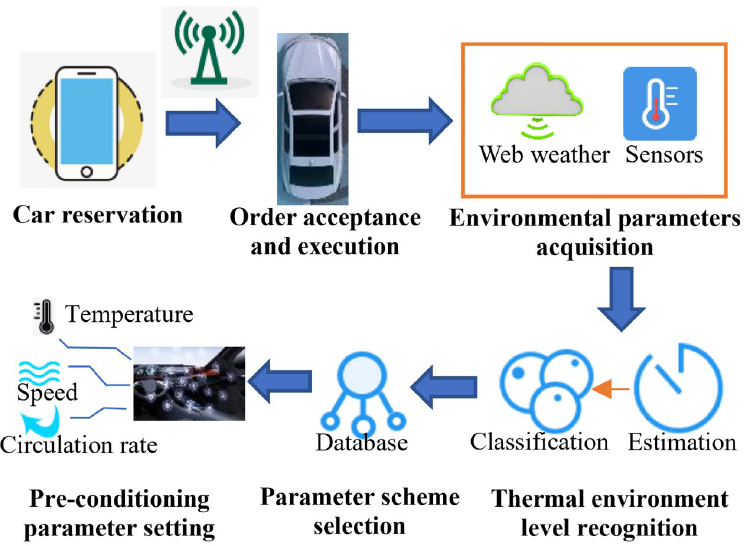
Fig 1. Implementation process of the vehicle HVAC pre-conditioning system. The system was designed for internet-enabled vehicles; therefore, passengers send network commands to activate parked vehicle systems for ventilation. The pre-conditioning system runs 10 minutes before passenger demand. The vehicle system specifies the optimal air conditioning parameters based on the current environmental conditions to the satisfy the passengers.